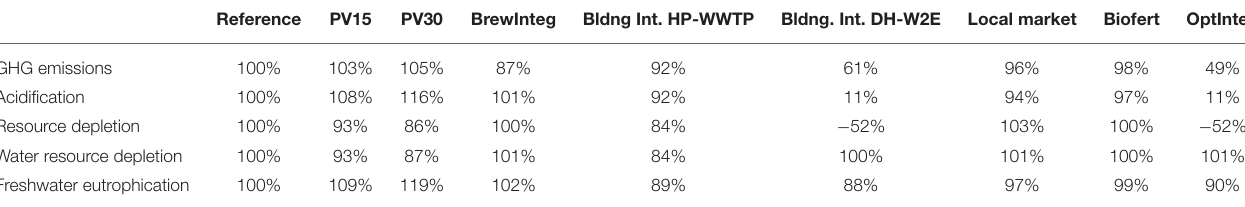
TABLE 2 | Comparison of the environmental impacts of different scenarios compared to the reference